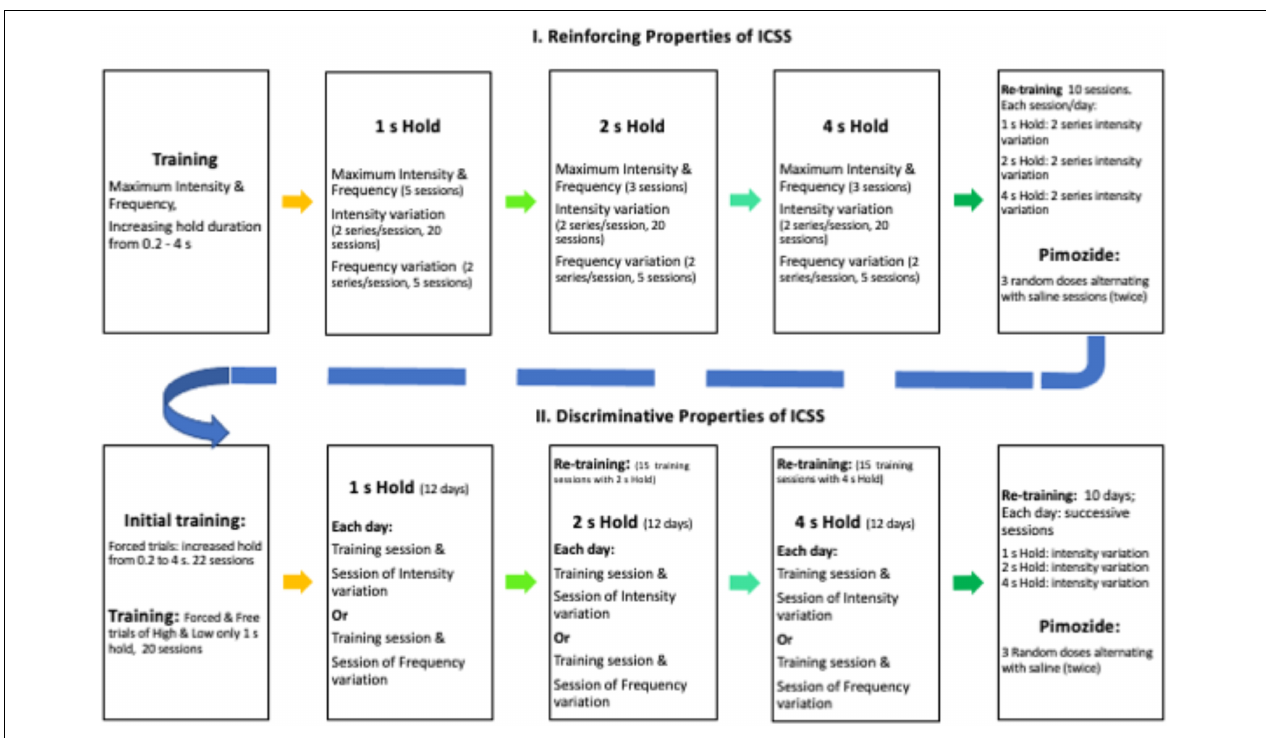
FIGURE 1 | Timeline of experimental conditions (see text for explanation).